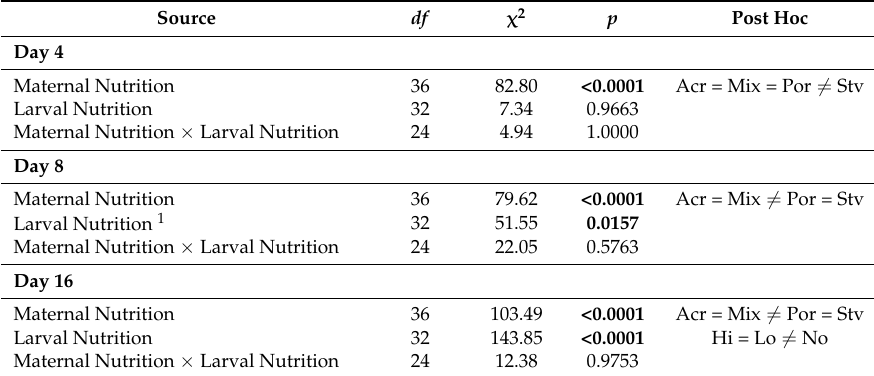
Table 2. Analysis of deviance for log-linear models testing complete and conditional dependence of larval development on maternal provisioning and larval diet at 4, 8, and 16 days.